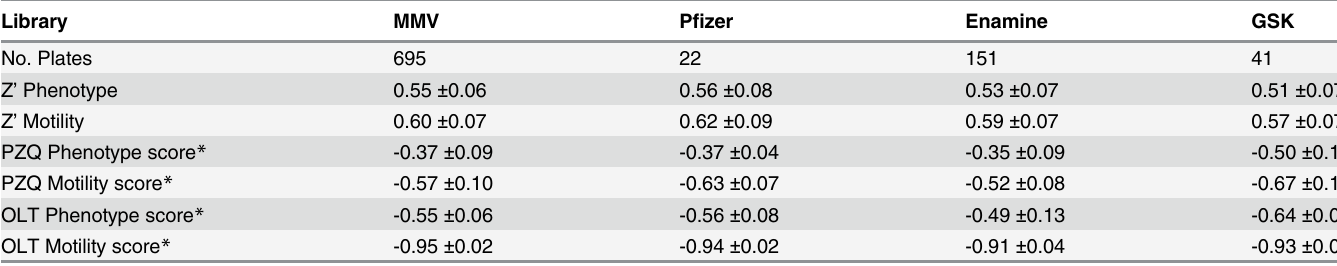
Overall 294,253 compounds were tested in the HTS. Table 1 shows the mean Z ’ factors for the plates in each of the different compound collections along with the mean phenotype and motil- ity scores for the OLT and the PZQ control wells. The mean Z ’ factors for both the phenotype and motility scores were consistently above 0.5 and essentially similar both within and between the different libraries, indicating that this is a robust assay. Similarly the mean phenotype and motility scores for both OLT and PZQ were broadly consistent within and between the